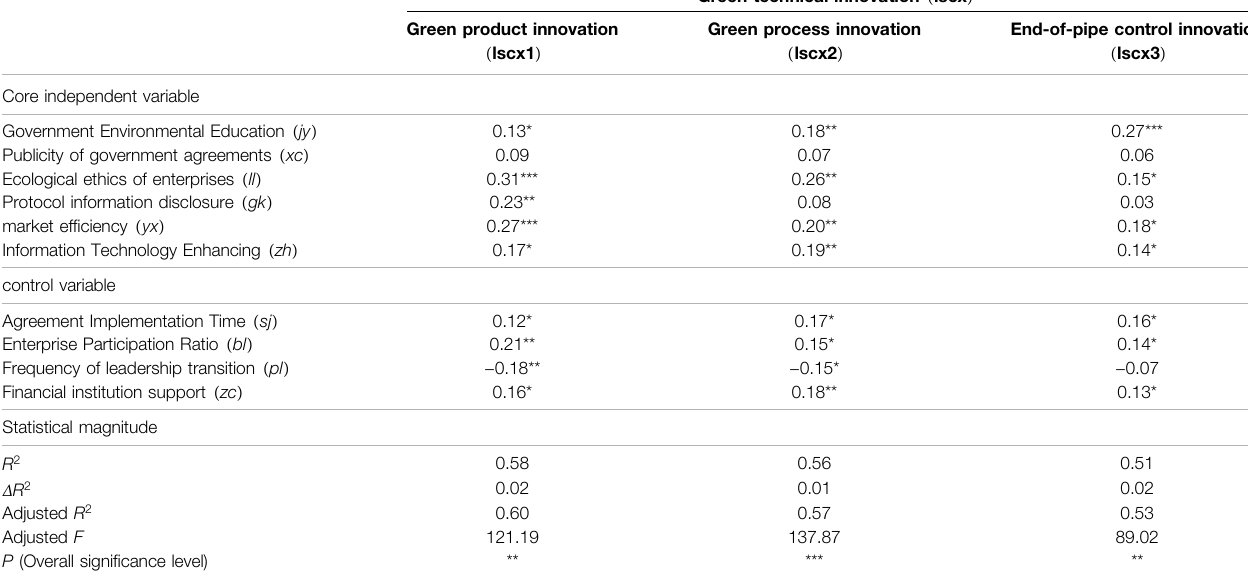
TABLE 5 | Empirical test of model.